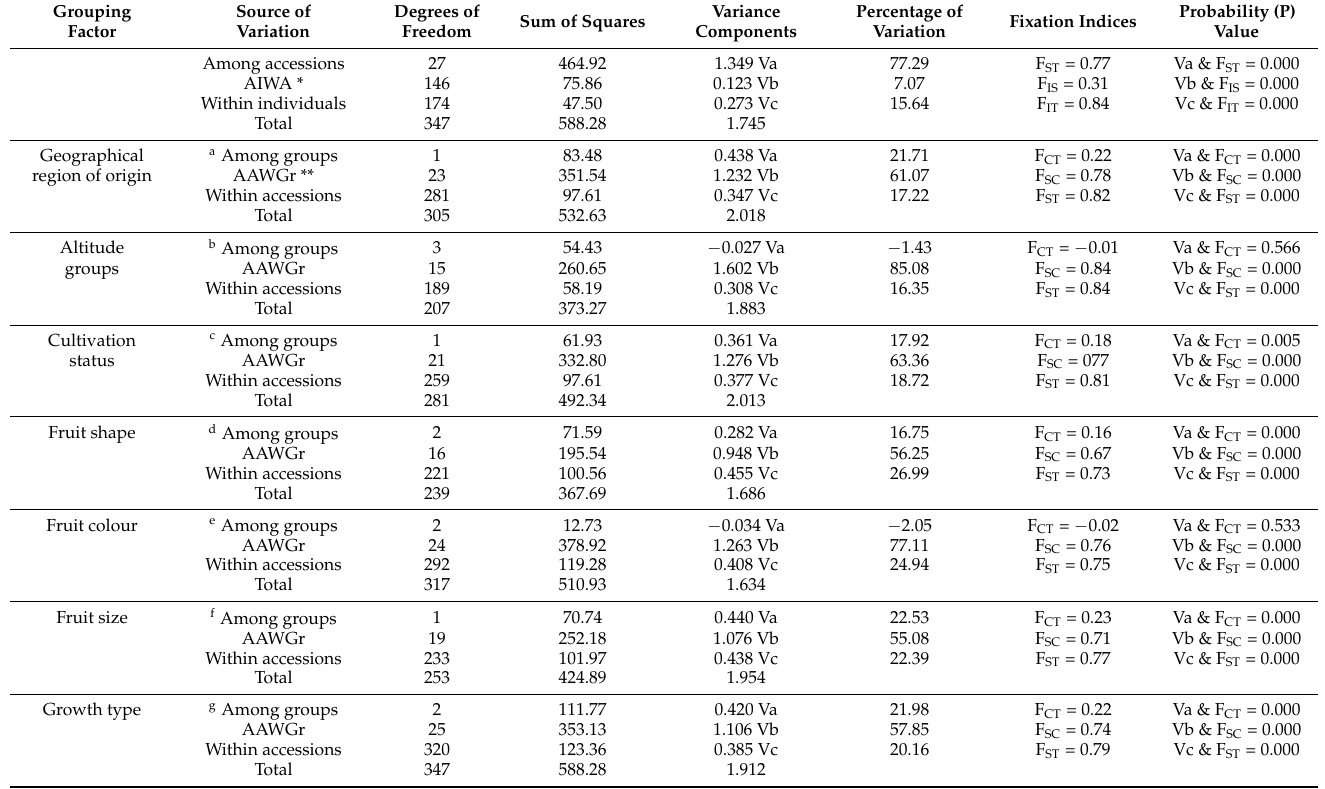
Table 4. Results of analysis of molecular variance (AMOVA) based on 1000 permutations without grouping the accessions and on grouping them according to geographical region of origin, altitude, cultivation status, fruit shape, fruit colour, fruit size and growth